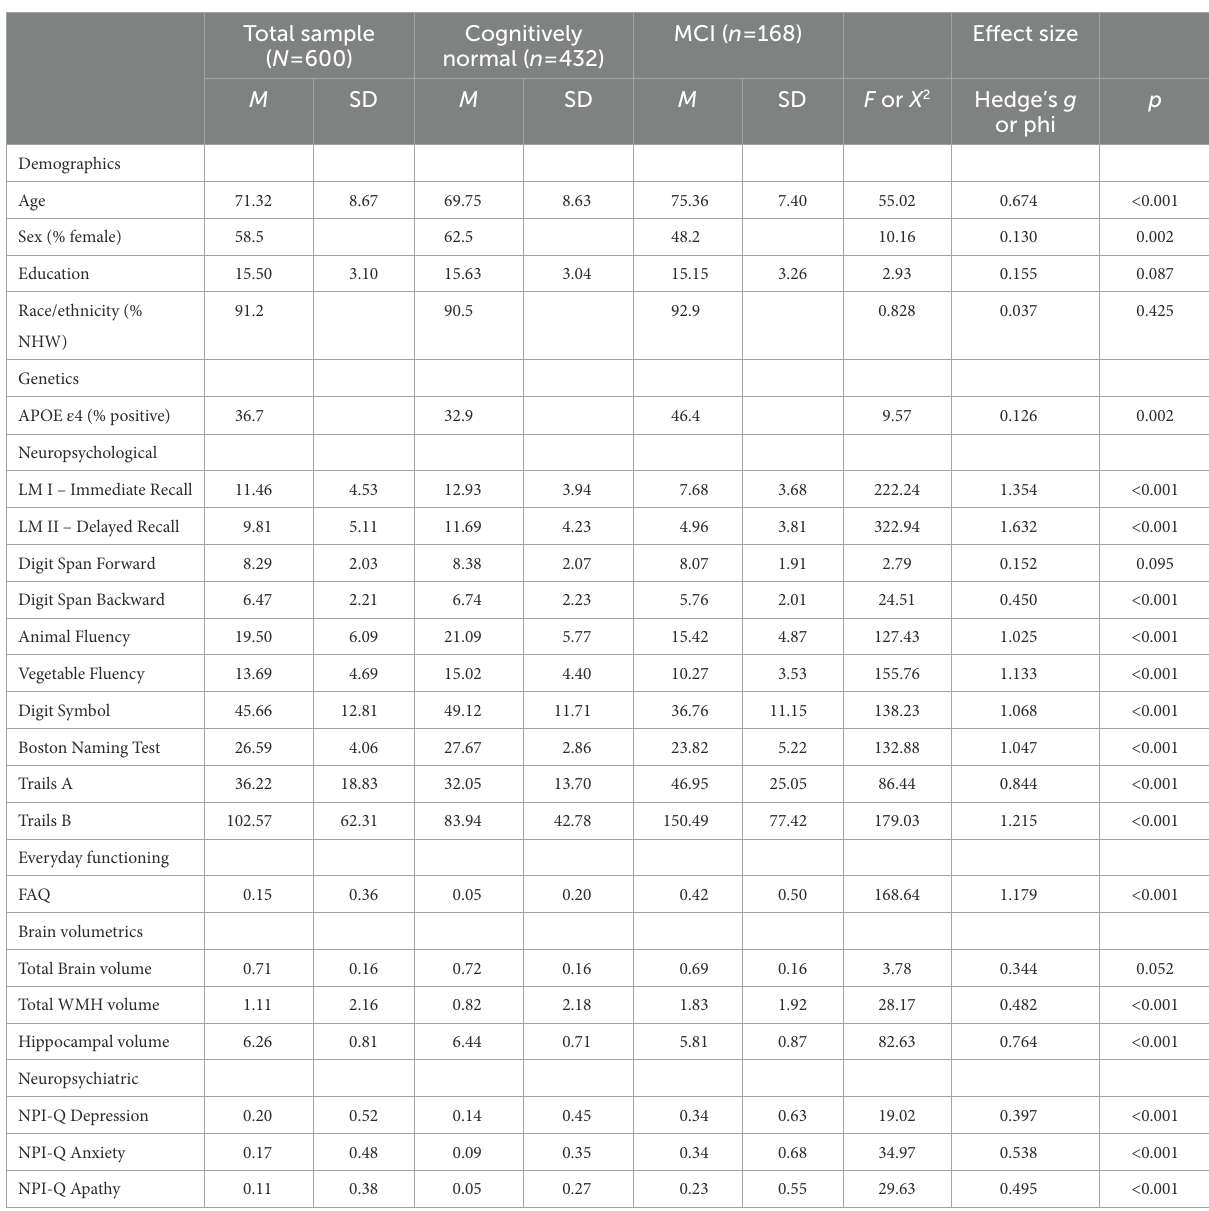
TABLE 1 Participant